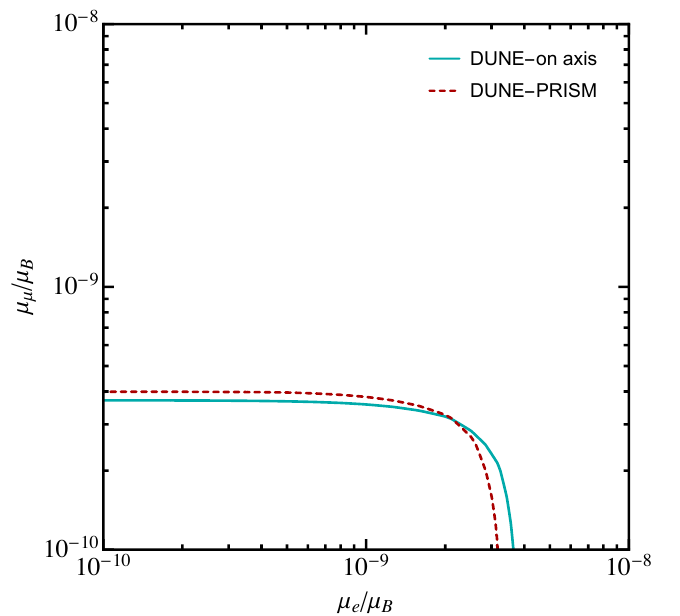
Figure 3 . Here we summarize our projected 90 % C.L. constraints from DUNE on the neutrino magnetic dipole moment in both a fully on-axis scenario (solid cyan) as well as an off-axis DUNE- PRISM setup (dashed red). See text for details about the DUNE-PRISM